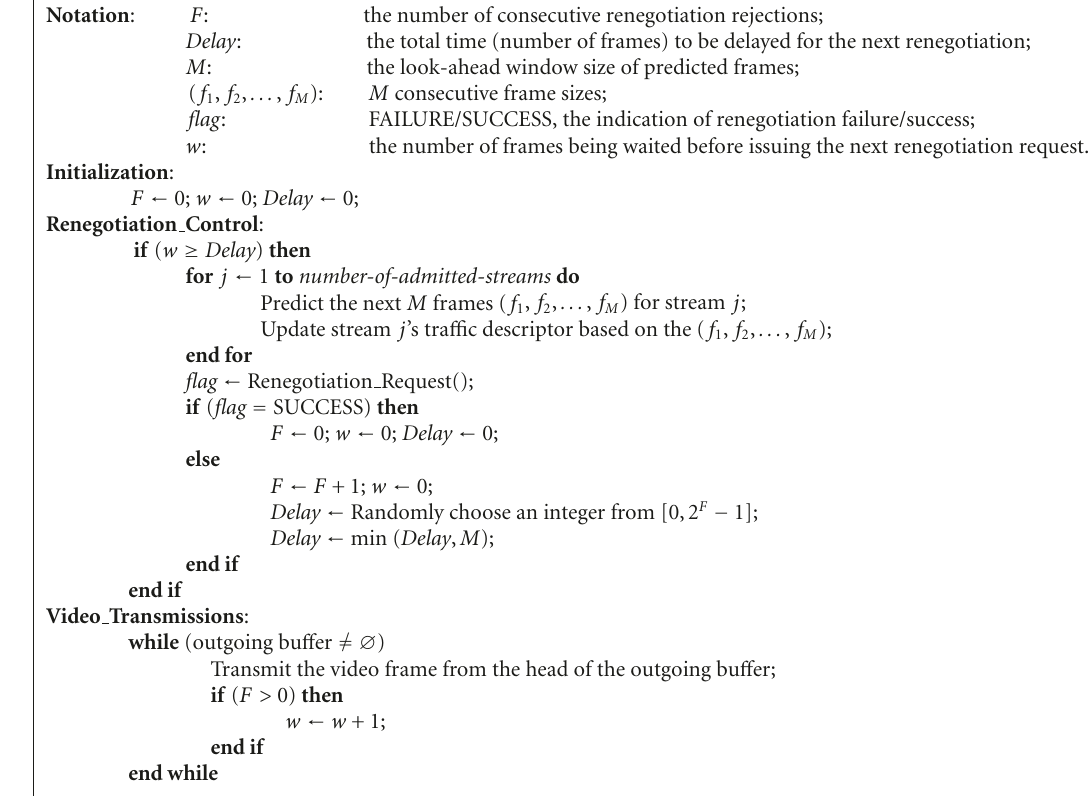
Algorithm 1: A BEB-based renegotiation control algorithm.